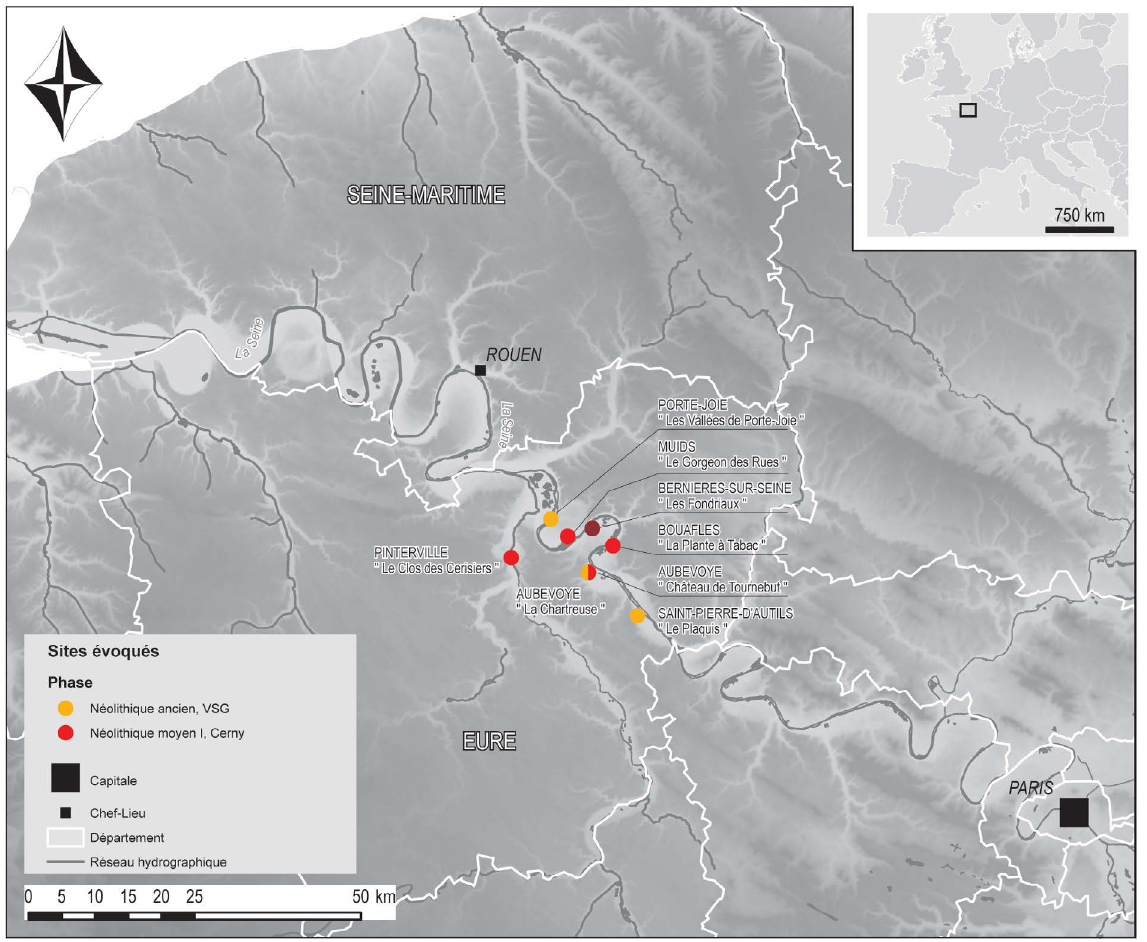
Figure 1. Localisation géographique des sites étudiés. (DAO C. Font, fond de carte SRTM). Figure 1. Geographical location of studied sites (CAD by C. Font, base map from the SRTM).